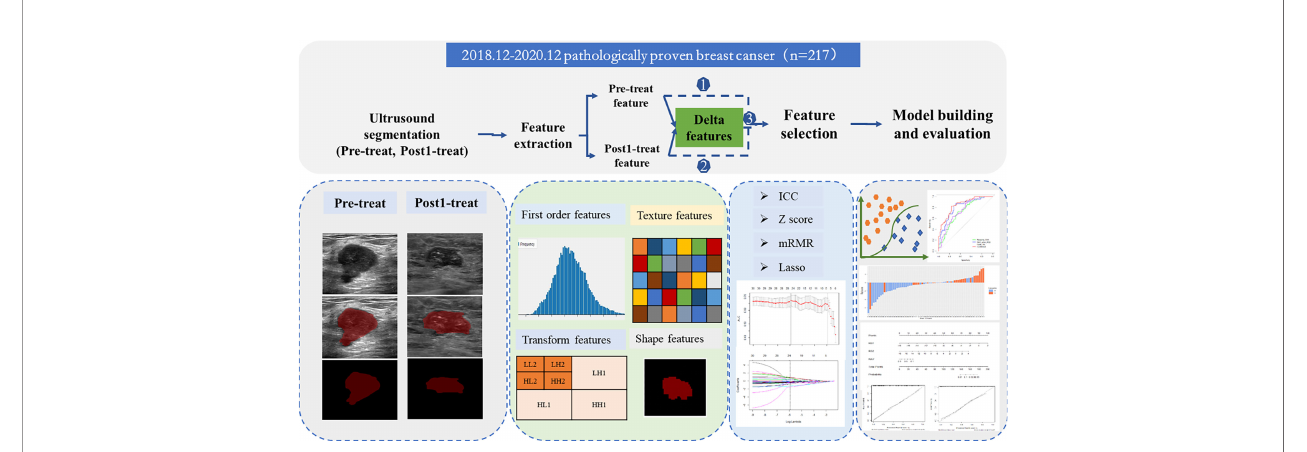
FIGURE 2 | A fl owchart of the processing step using the radiomic method for predicting NAC